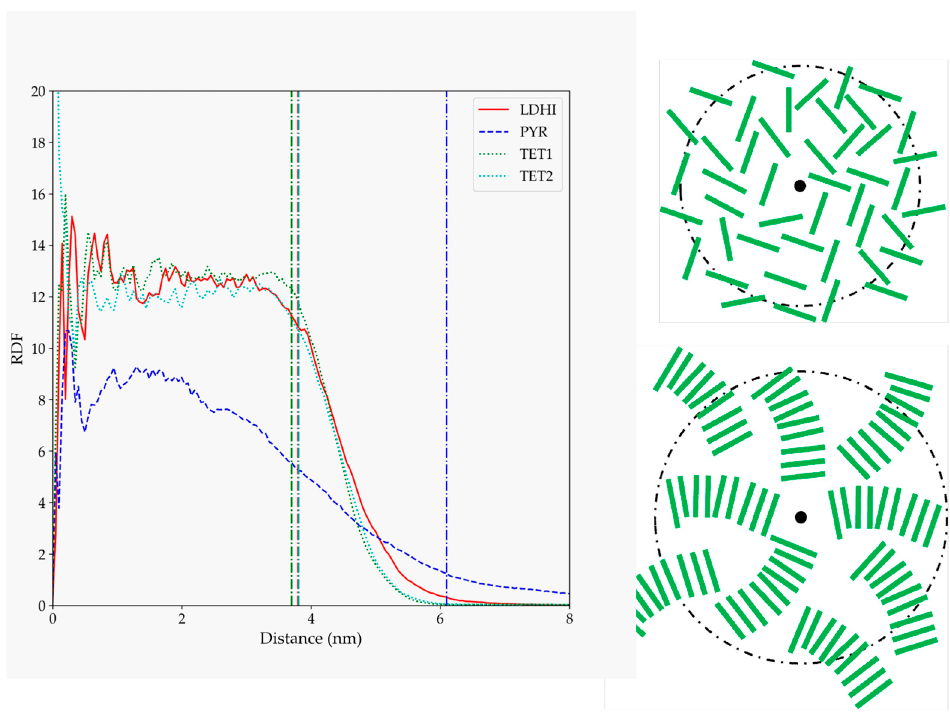
Figure 4. RDF for PDA atoms relative to the position of the nanosphere center of mass for the four models considered in solution ( l DHI: red; PYR: blue; TET-1: green; TET-2: cyan). All the profiles are averaged for the three configurations generated for each model. The vertical lines indicate the average approximate value of the radius of gyration for each of the systems. The schemes on the right are simplified depictions proposed for l DHI, TET-1, and TET-2 ( top ), and for PYR ( bottom ) from the overall geometry and the RDF profiles.